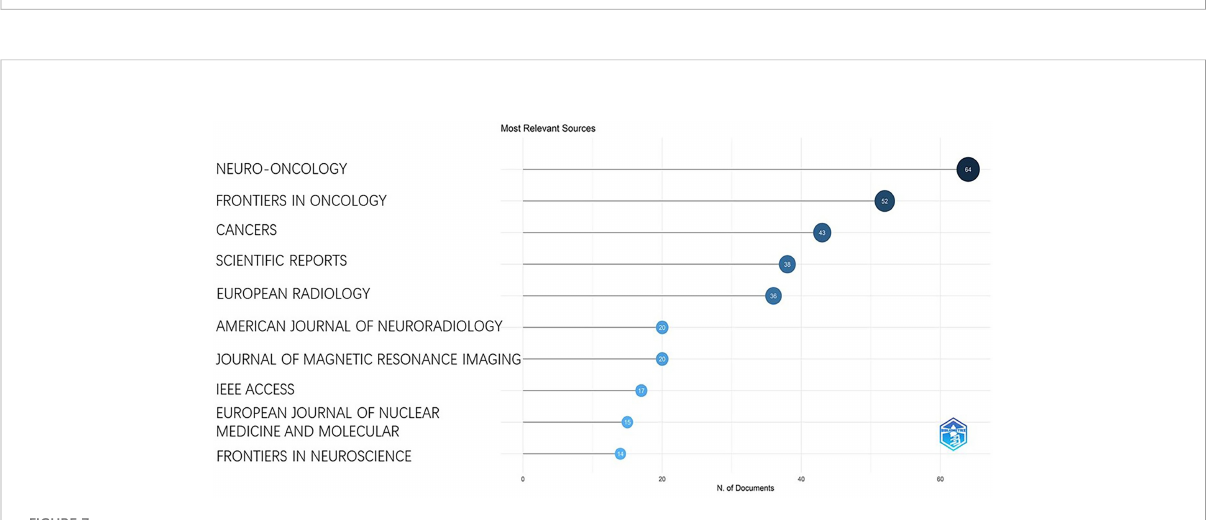
FIGURE 7 It shows the number of publications in different